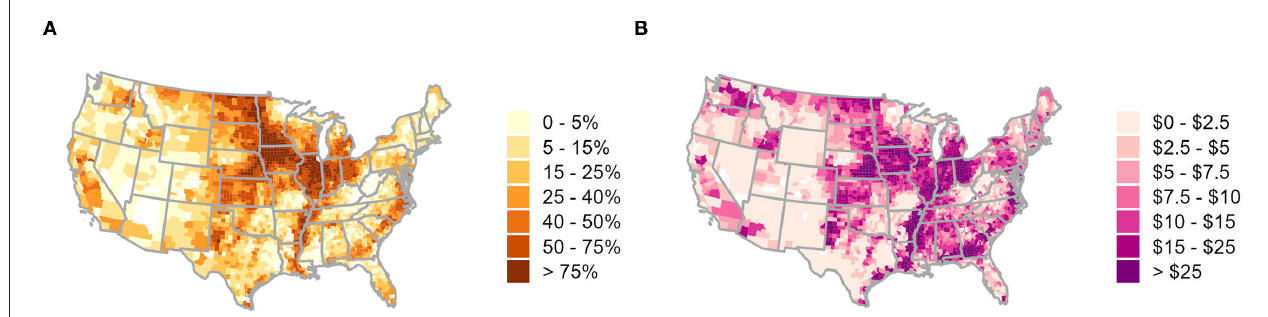
FIGURE 8 | (A) Percent of county agricultural acres covered by crop insurance in 2017; (B) Dollars provided per agricultural acre in government payouts to farmers in 2017. In 2017, US farms received an average of $11.59/acre (median = $8.69/acre) in government payments and an estimated 31.1% (median = 23.9%) of all agricultural acres were covered by crop insurance ( Figure 12 ). Data: USDA NASS